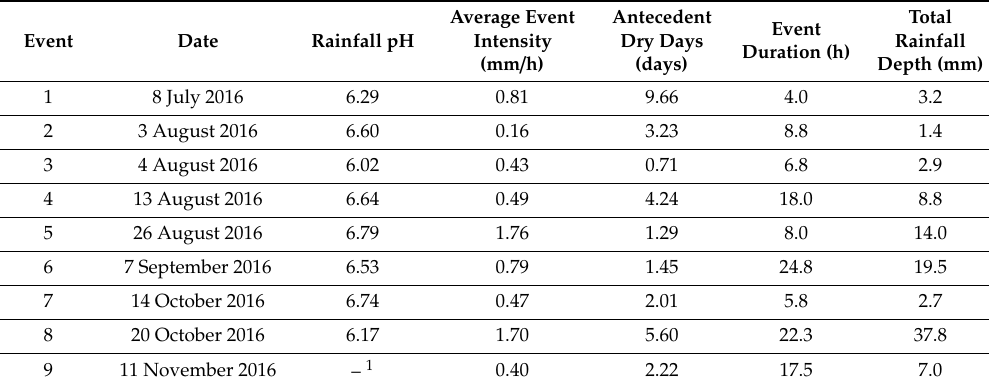
Table A2. Heathcote sampled event characteristics, used for validation.